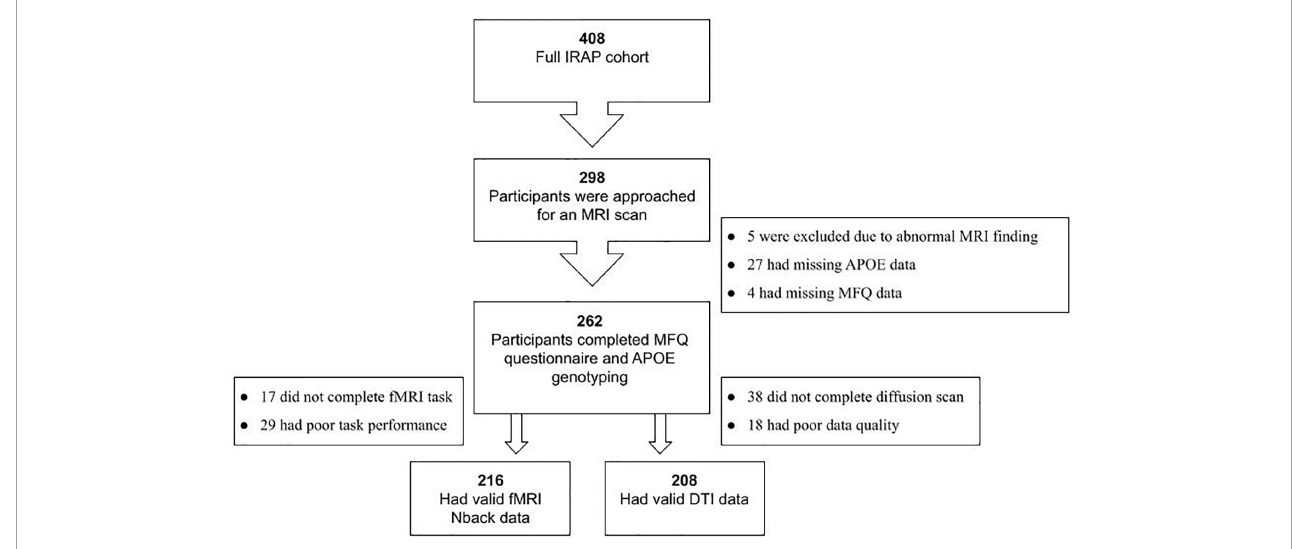
FIGURE1 Flowchart of the study cohort. IRA P , Israel Registry for Alzheimer’s Prevention; FH, parental family history of AD; MRI, magnetic resonance imaging; MFQ, Memory Functioning Questionnaire; APOE , apolipoprotein E gene; fMRI, functional MRI; DTI, diffusion tensor